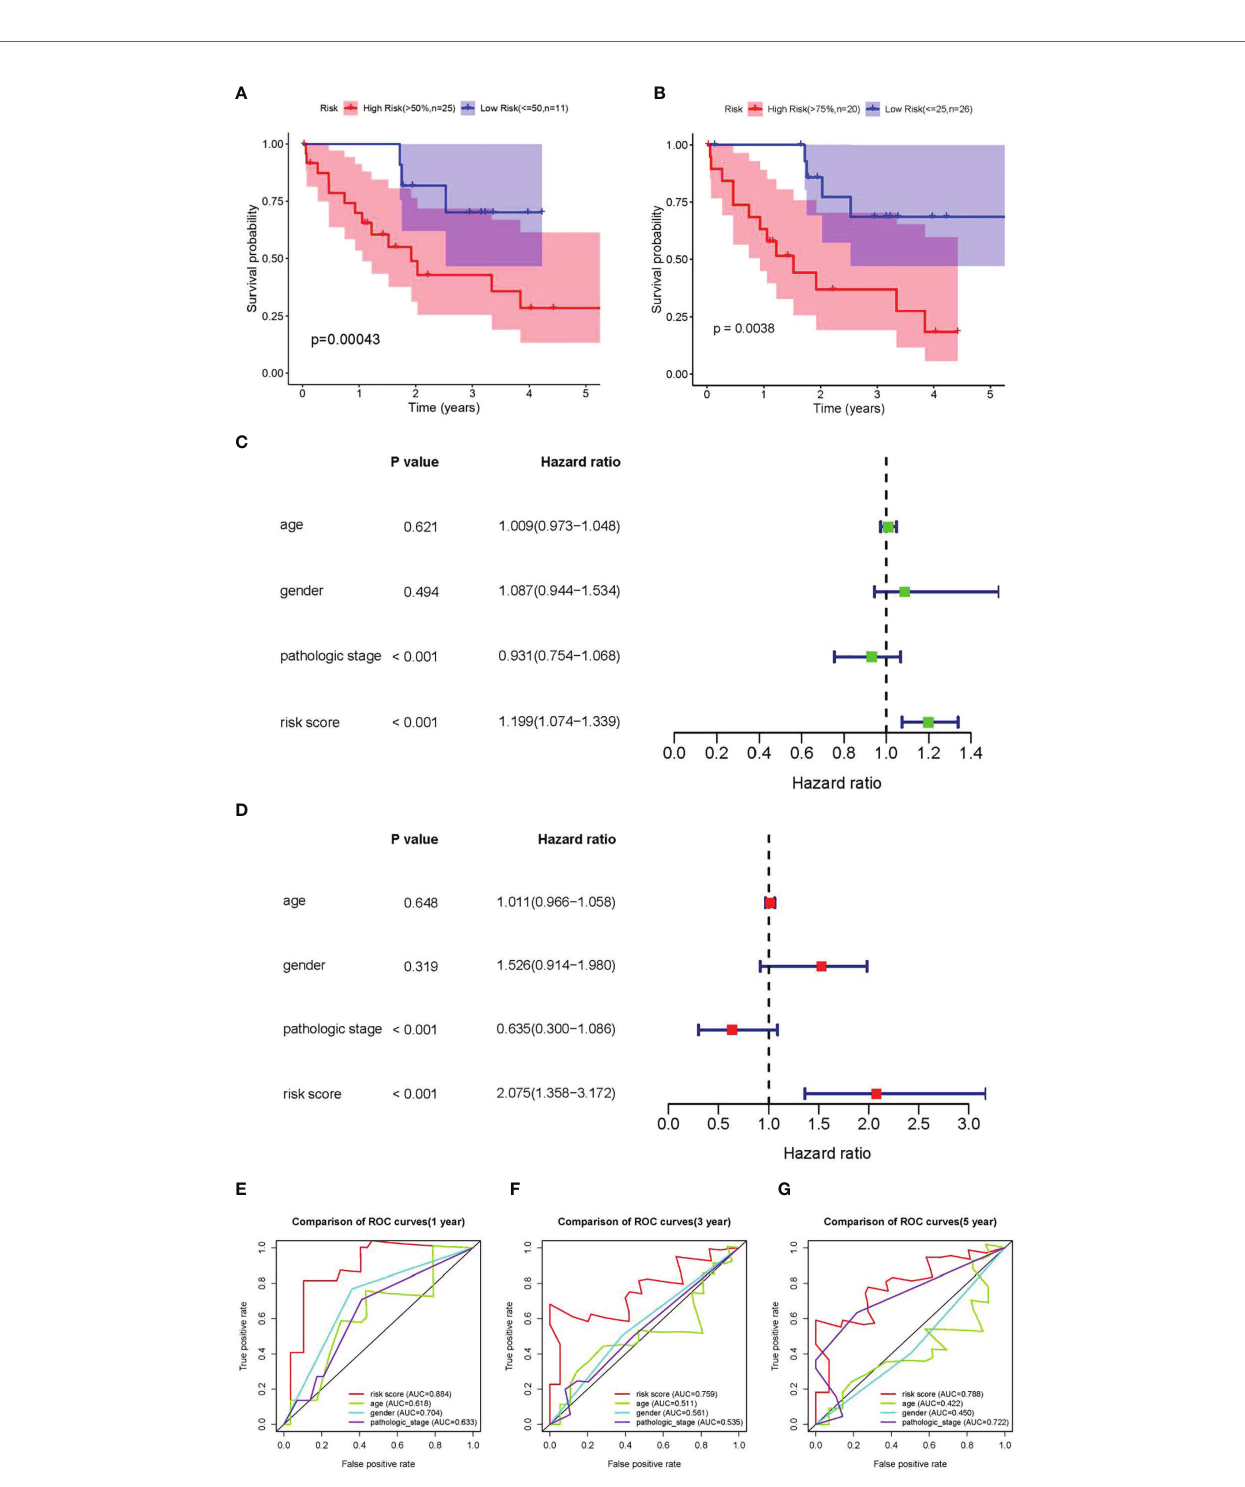
Frontiers in Oncology |